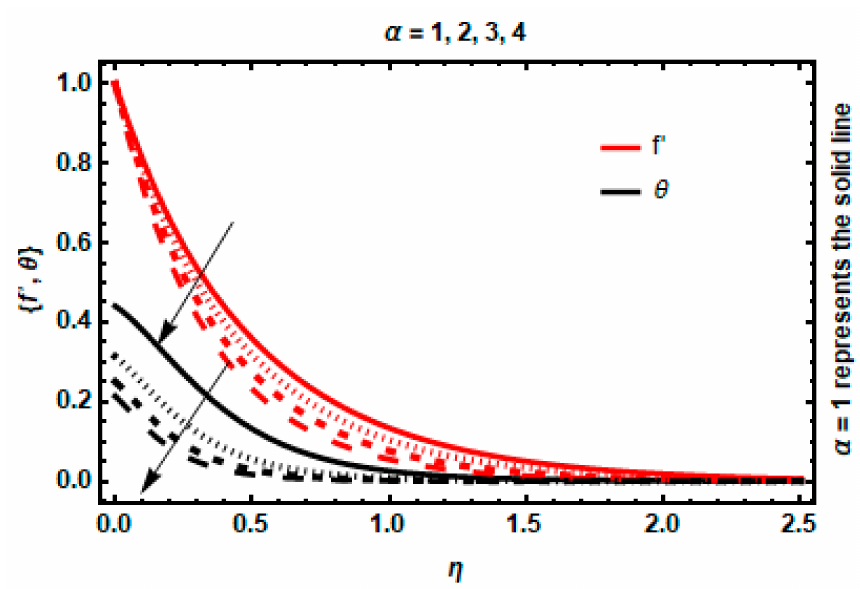
Figure 5. Impact of α on velocity and